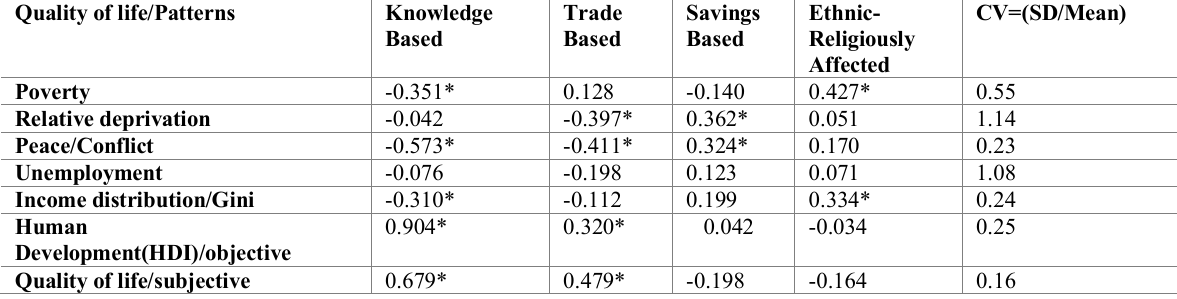
Table 5: Pattern of economic growth and quality of life: